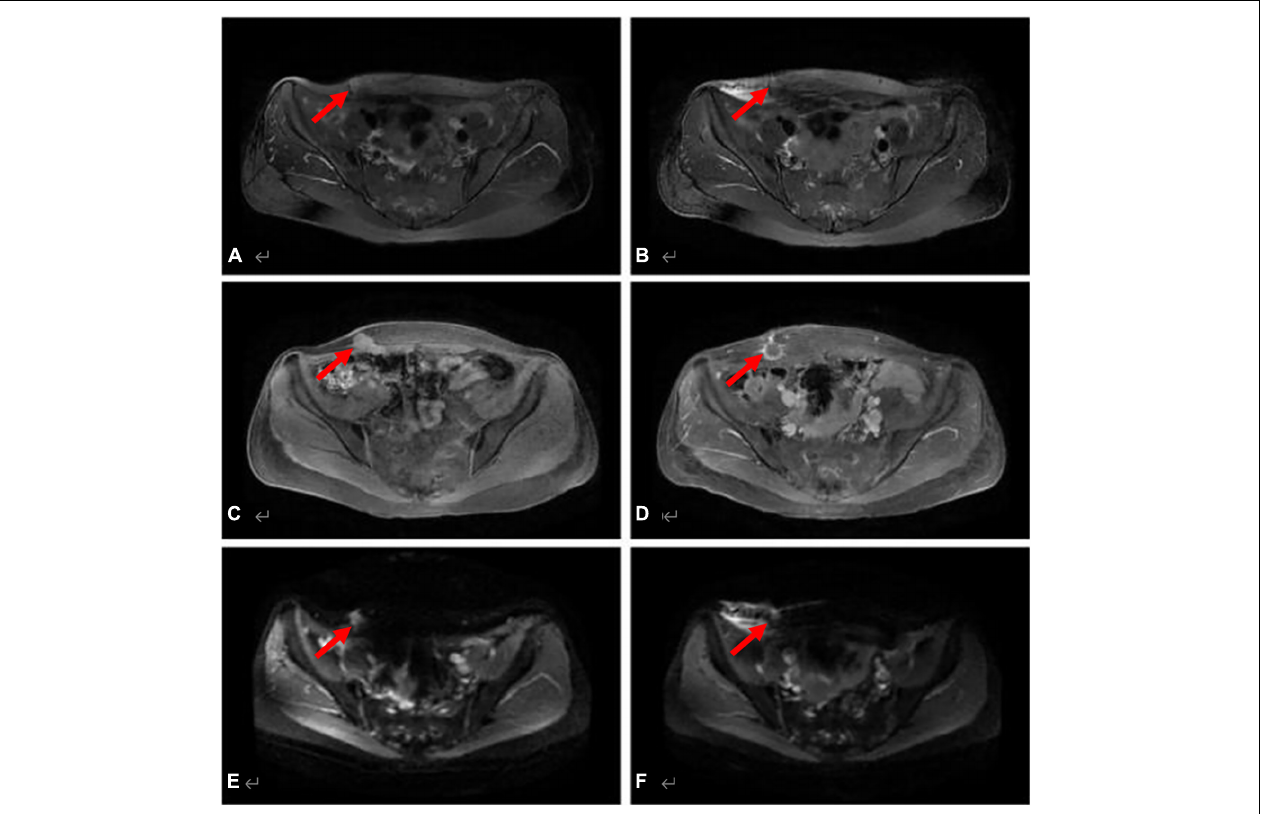
FIGURE 5 | DWI sequence for a 35-year-old patient before and after HIFU treatment. The AWE lesion located at the right corner site of the surgical scar. This chart shows a comparison between pre- and post-treatment. (A) Axial T2WI with fat-suppression shows that the lesion appeared slightly hyper-intense (red arrow) pre-operatively. (B) Axial T2WI shows the same lesion (red arrow) appeared as signal reduction post-ablation, and the high signal in the surrounding tissue represents edema. (C,D) Axial contrast imaging showed evident enhancement pre-treatment (red arrow) and revealed non-enhancing areas of post-treatment (red arrow). (E,F) On DWI, the lesion showed high signal pre-operatively, the ADC value was 1.7 × 10 − 3 mm 2 /s ( b = 600 s/mm 2 ), which showed slightly low signal post-treatment, and the ADC value was 2.7 × 10 − 3 mm 2 /s ( b = 600 s/mm 2